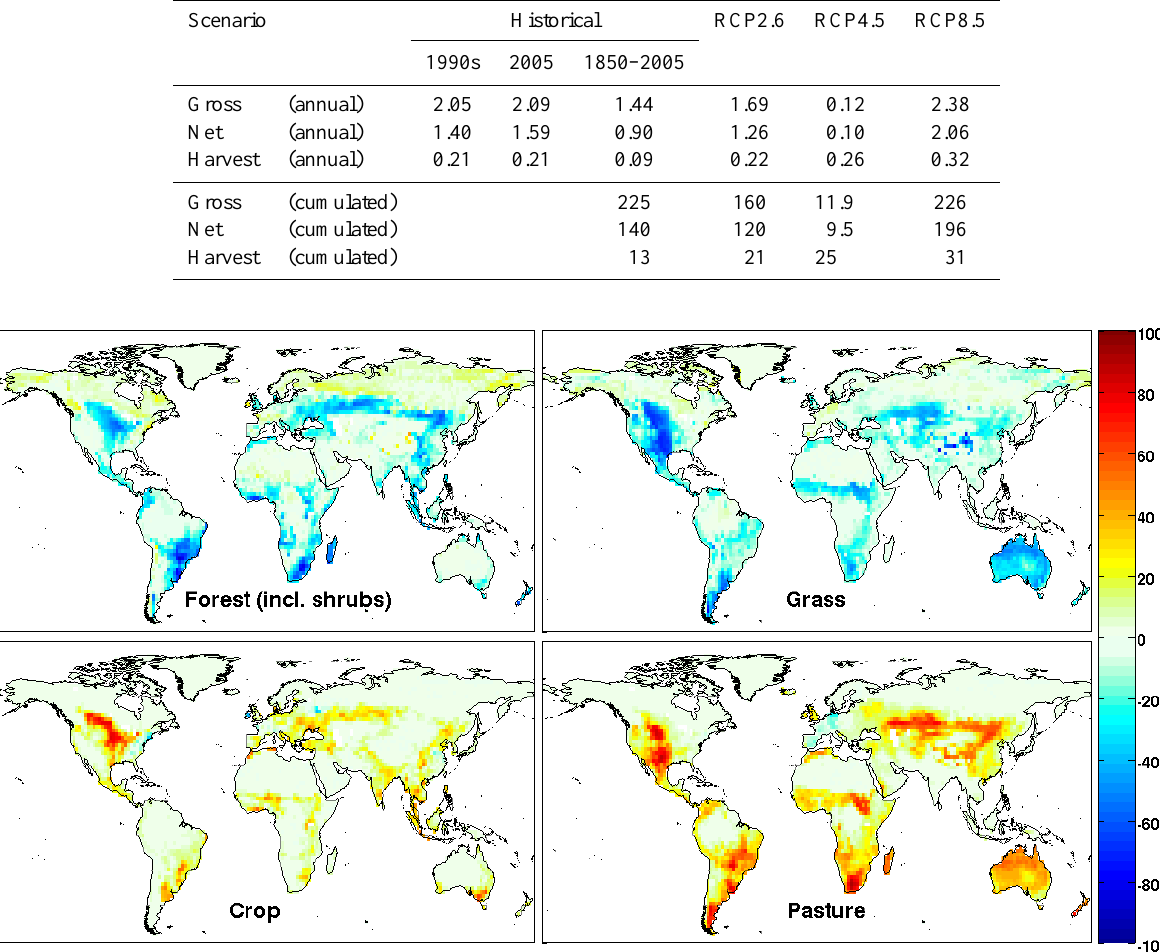
Table 2. Annual average LCE [PgCyr − 1 ] and LCE accumulated over entire experiment [PgC]. Scenario “historical” calculated from ex- periments hist_gross (hist_net) and hist_ref, experiments “RCP” from RCP_gross (RCP_net) and RCP_ref. “Harvest” is calculated from the difference between hist_none (RCP_none) and hist_harv (RCP_harv). The LCE from wood harvest is included in the numbers for both “gross” and “net”.